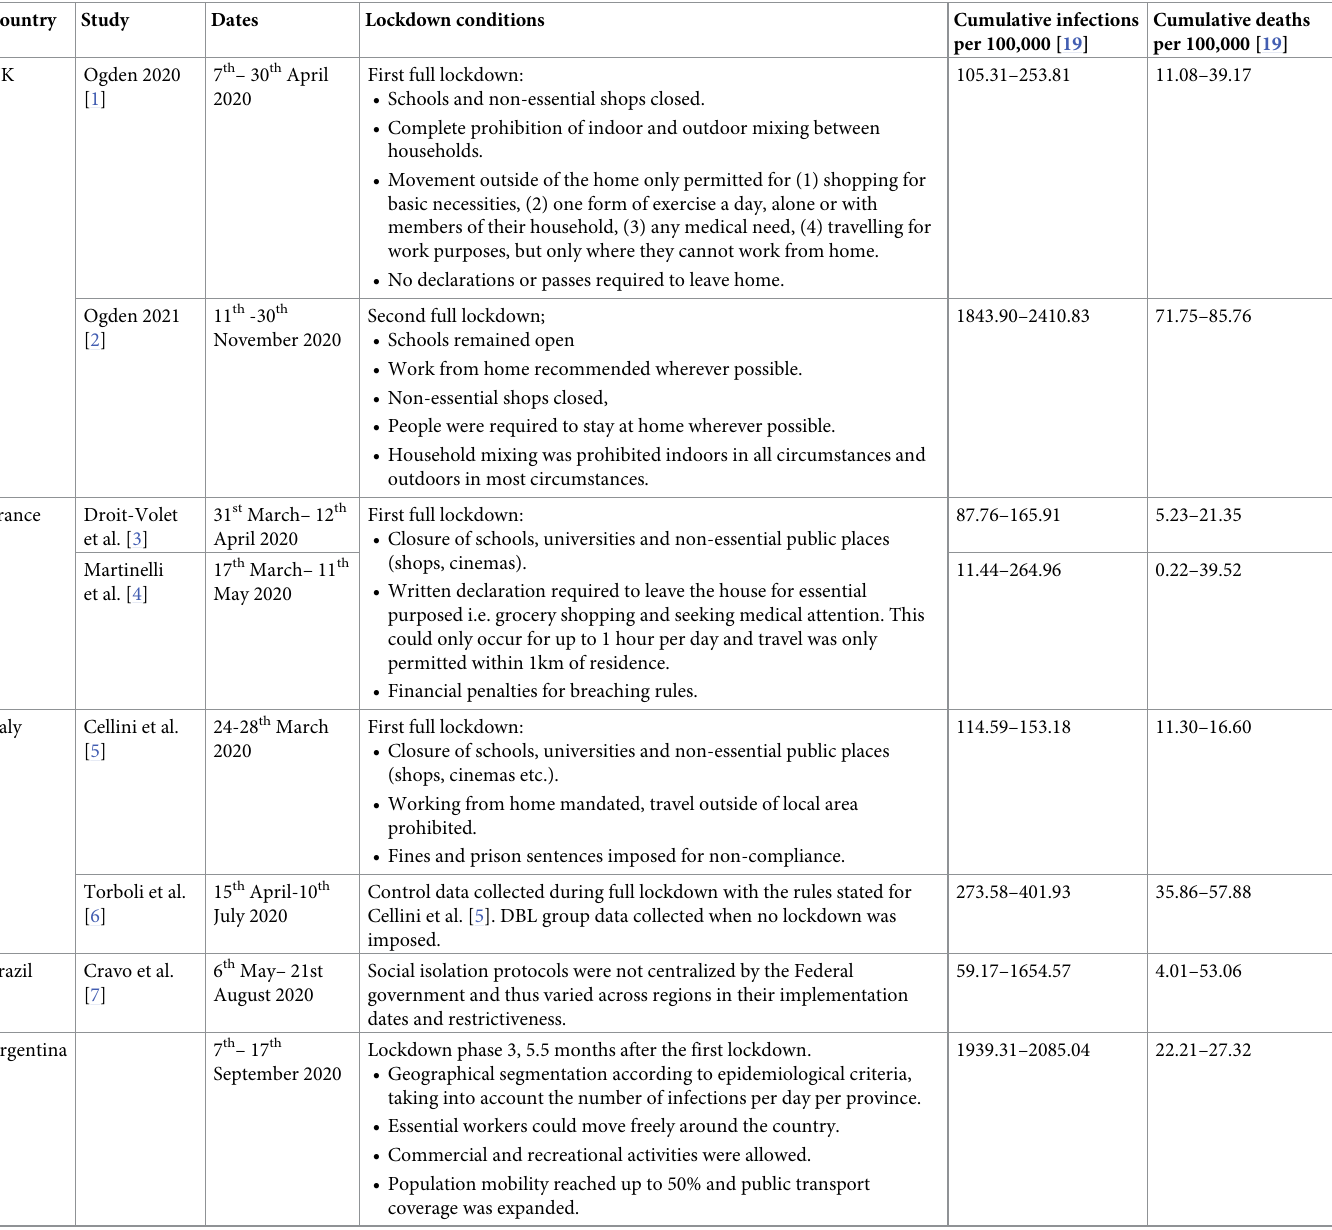
Table 1. Lockdown restrictions, cumulative infections per 100,000 and deaths per 100,000 in the UK, France, Italy, Brazil and Argentina during the times of data